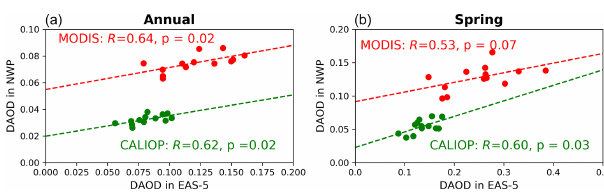
Figure 17. Correlation between DAOD in EAS-5 (southern Gobi Desert) and DAOD in NWP for annual mean (a) and springtime average (b)